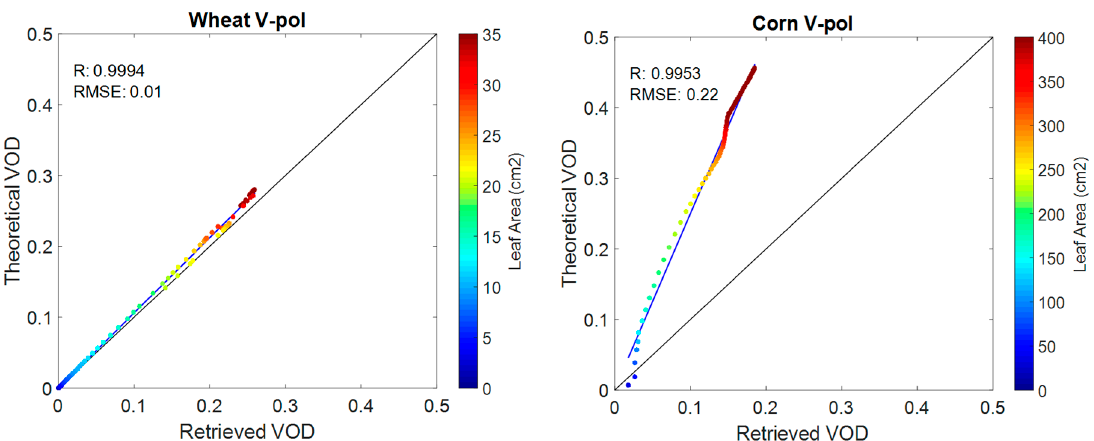
Figure 7. Comparison of VOD s and VOD T ( left : wheat, right : corn) with the color bar indicating the single leaf area (cm 2 )